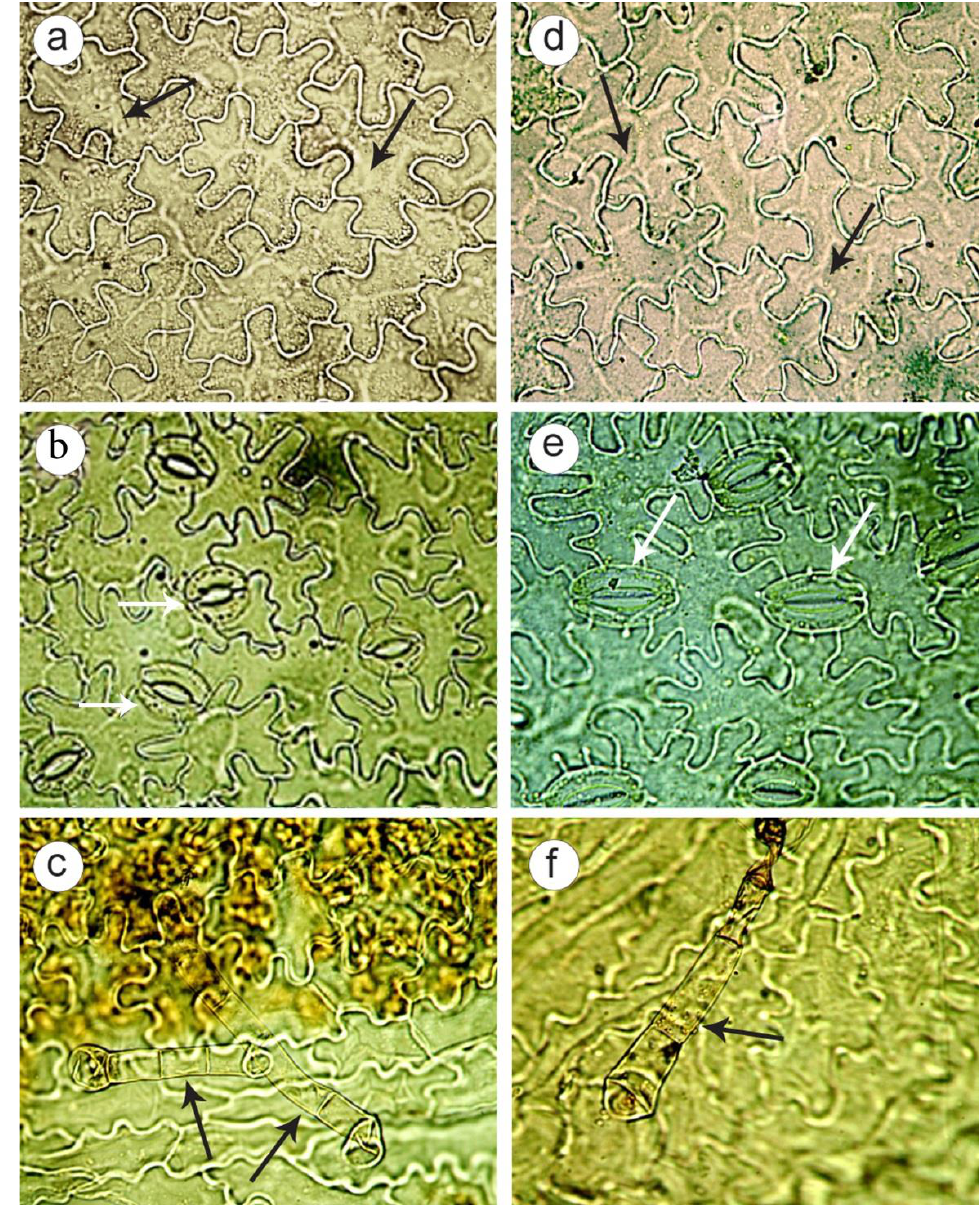
Figure 7. Comparative characterization of leaf epidermis in the diploid ( a – c ) and tetraploid ( d – f ) plants of Polemonium caeruleum L. ( a , d ) Cells with winding walls on the upper epidermis of a leaf (×400; black arrows); ( b , e ) cells with winding walls and stomata on the lower epidermis of the leaf (×400); white arrows; ( c , f ) glandular hairs along the leaf vein (×400; black arrows). Above the veins, epidermal cells were elongated and had a rectangular spin- Along the margin of both sides of the leaf, the epidermal cells were thick-walled and dle-shaped form. Glandular hairs were detected along the leaf veins and outgrowths of extended into papillae. In leaves of the colchicine-induced tetraploid plants, the predomi- the epidermis along the edge of the leaves. On the lower side of the leaf epidermis, nance of large stomata (Figure 7e) was revealed unlike the control plants (Figure 7b). Diploid plants had stomata with a smaller diameter as well as a lower frequency of stomata per unit leaf area compared to tetraploids (Table 2, Figure 7b,e). These results showed that stomata can be important indicators for the determination of ploidy level in P. caeruleum